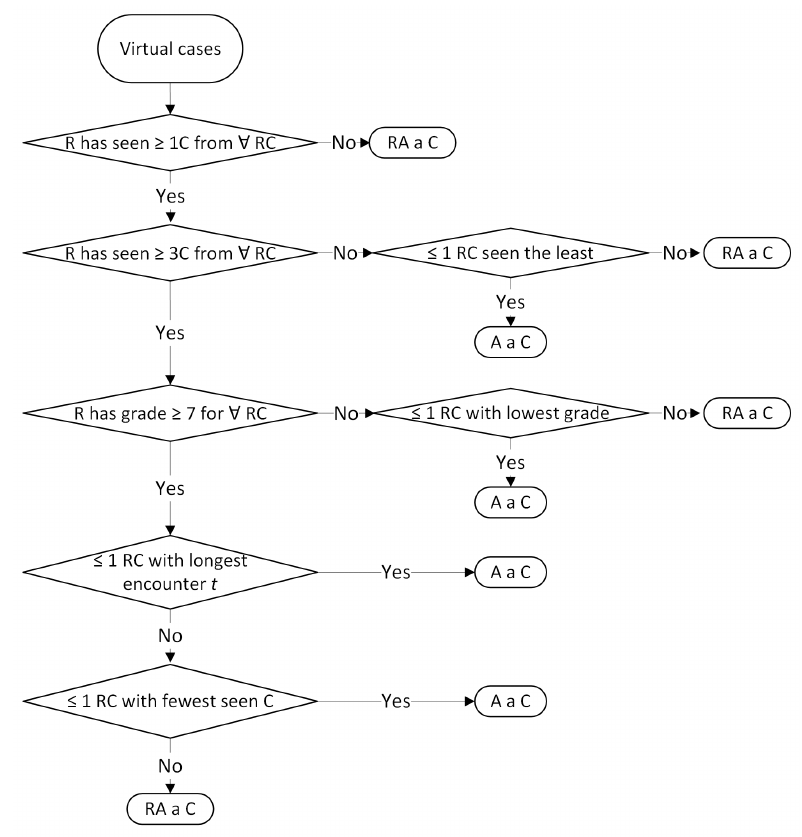
Figure A2. Rules for assigning virtual cases (A = assign; C = case; R = resident; RA = randomly assign; RCs = retinal conditions; t = time).